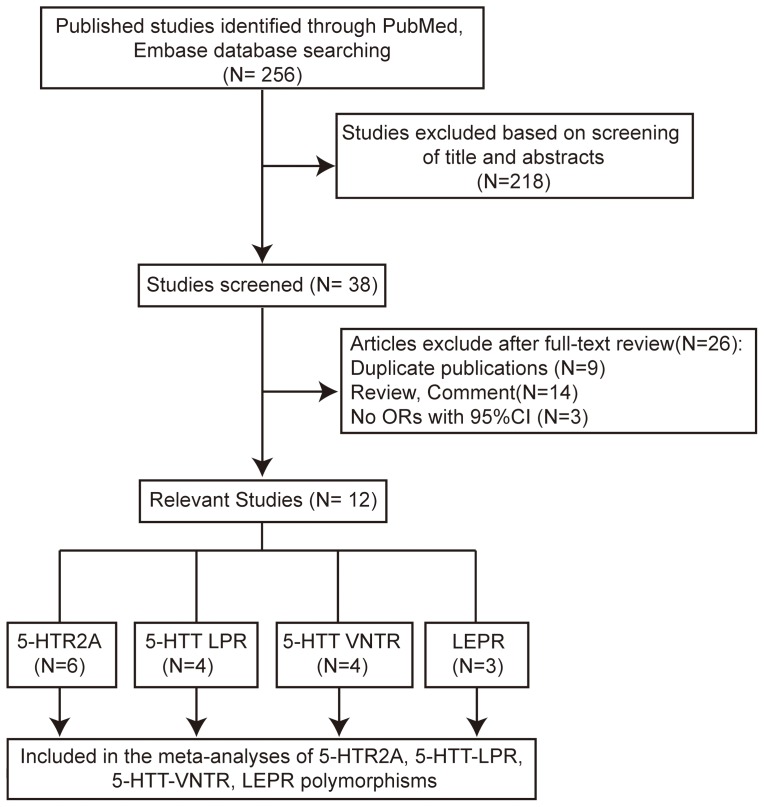
The flowchart showing articles identification, inclusion and exclusion.